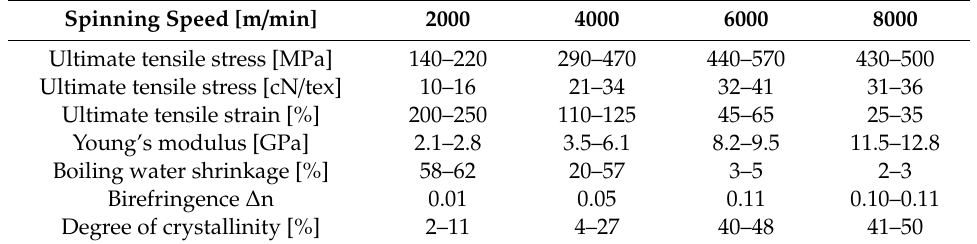
Table 4. Physical properties of PET filaments as a function of spinning speed (one-step process) [169].